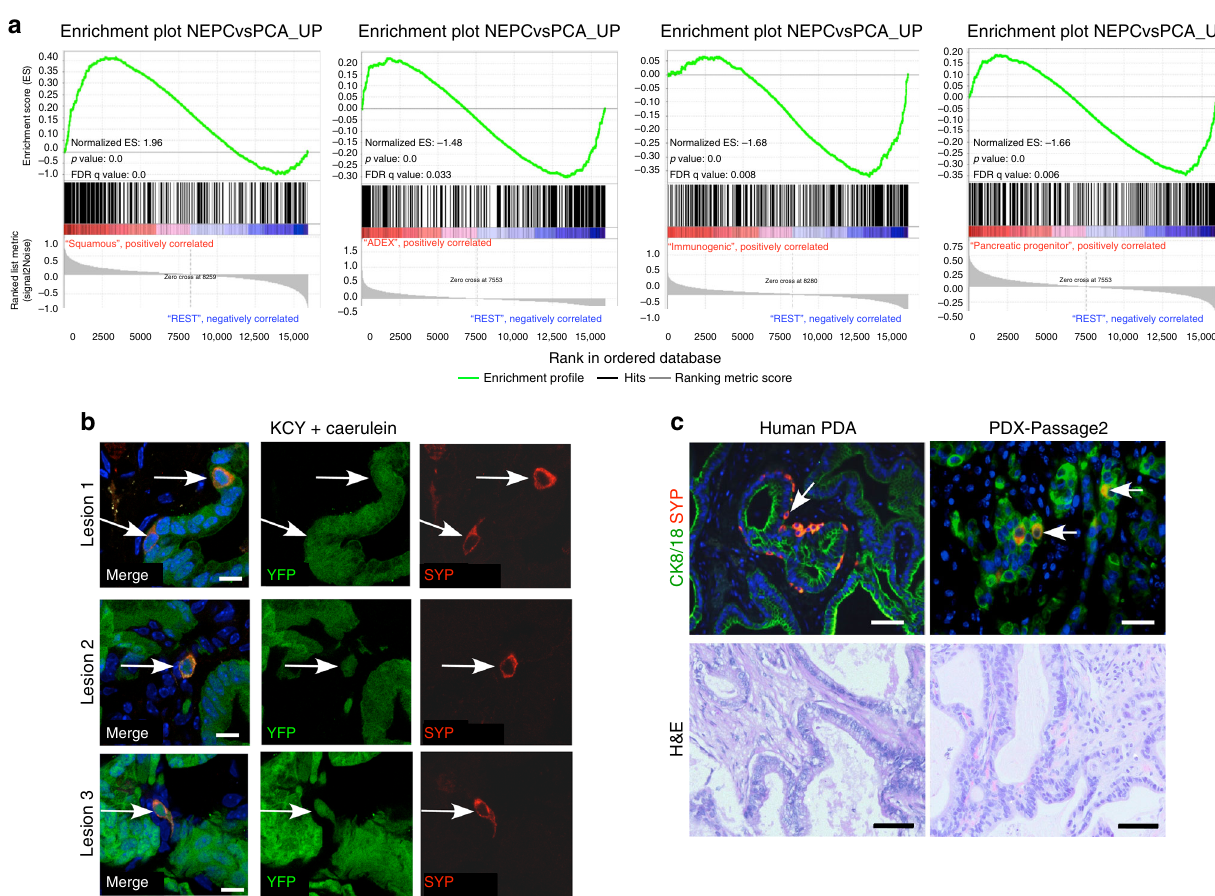
Fig. 2 Neuroendocrine differentiation can arise from acinar cells. a Gene set enrichment analysis (GSEA) demonstrating that genes upregulated in NEPC vs. PCA 11 are enriched in the squamous subtype of pancreatic cancer, compared to all other individual subtypes ( “ REST ” ). b Pancreatic tissue from KCY mice was stained for SYP and YFP. SYP-YFP dual positive tumor cells are marked with white arrows. Scale bar indicates 10 μ M. c CK-SYP dual positive cells are observed in serial-passaged patient-derived xenografts (PDXs). Both the primary patient sample and tissue after two passages through mice were stained with CK8/18 and SYP. Examples of co-stained cells are marked with white arrows. Corresponding H&E images are shown below. Scale bars